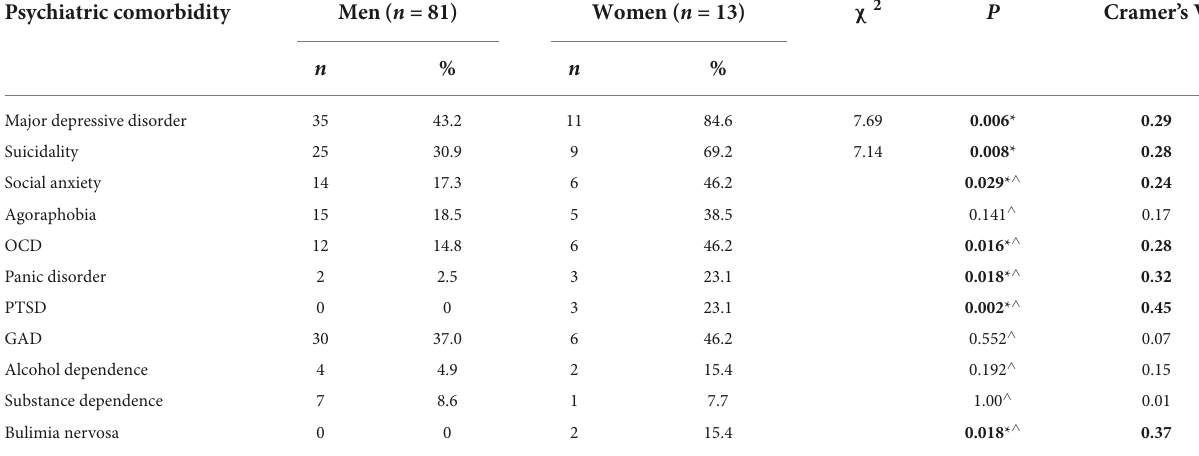
TABLE 2 Comparison of current psychiatric comorbidities between women and men. Psychiatric